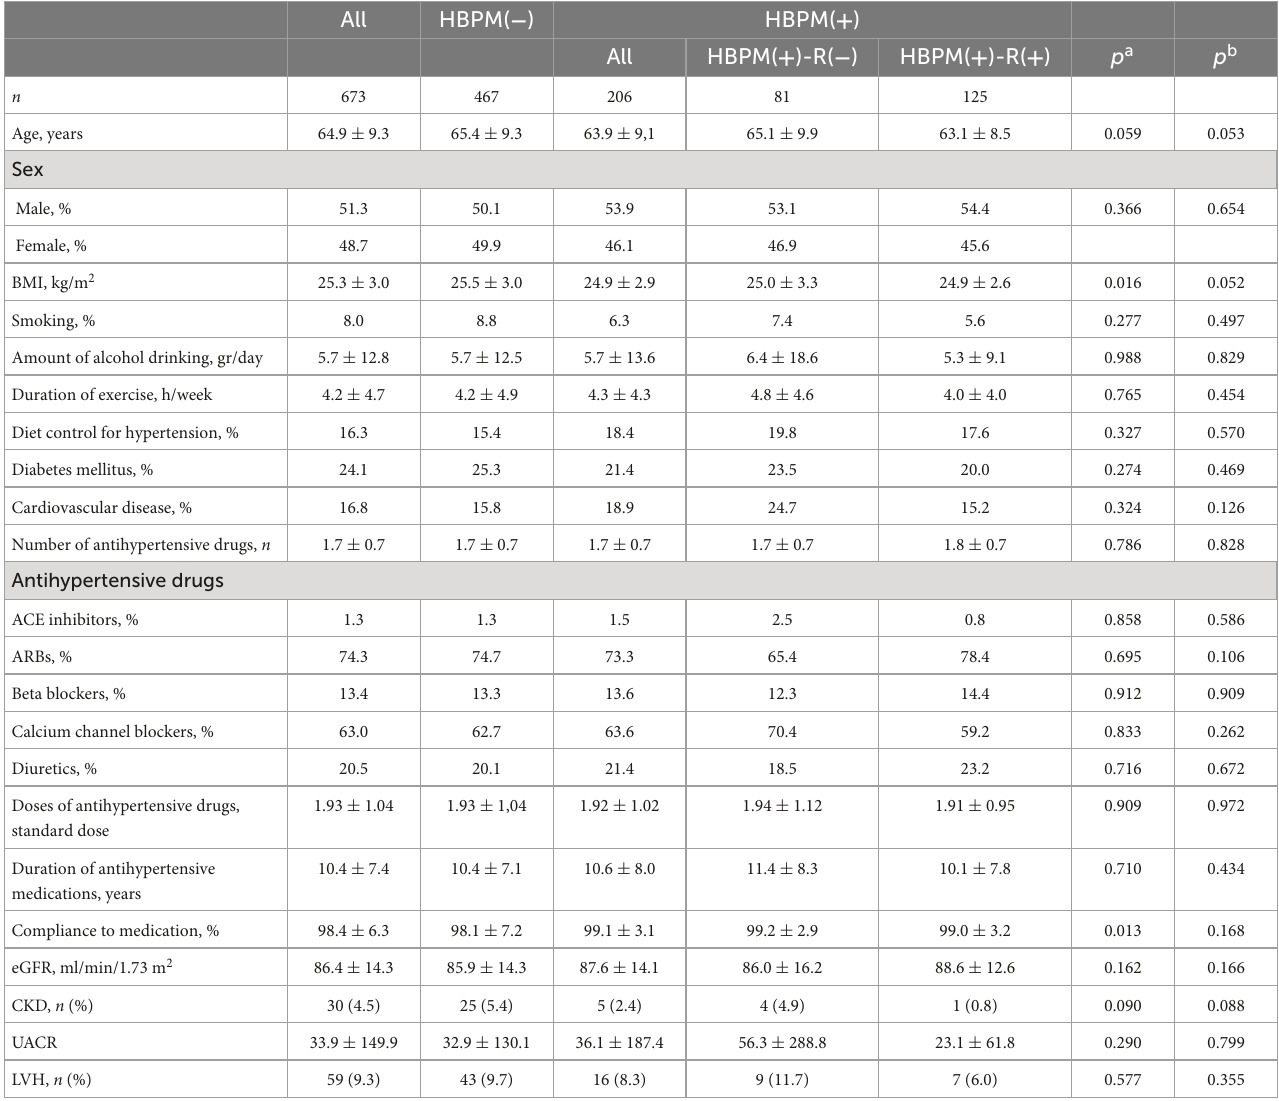
TABLE 2 Demographic and clinical characteristics of the study